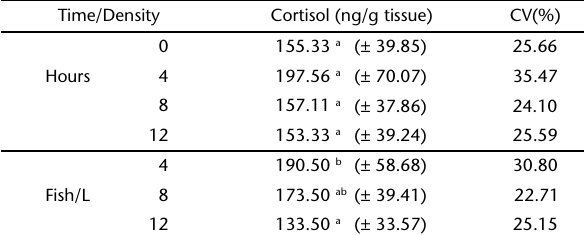
Table II. Cortisol (mean ± standard deviation) levels and its coefficient of variation (CV) obtained in simulated transport of fingerlings of Pimelodus maculatus for 0, 4, 8 and 12 hours in densities 4 (22.88 g/L), 8 (45.76 g/L) and 12 (68.64 g/L) fish/L. Different letters indicate significant differences among groups in the same day by two-way ANOVA and Tukey test (p < 0.05).